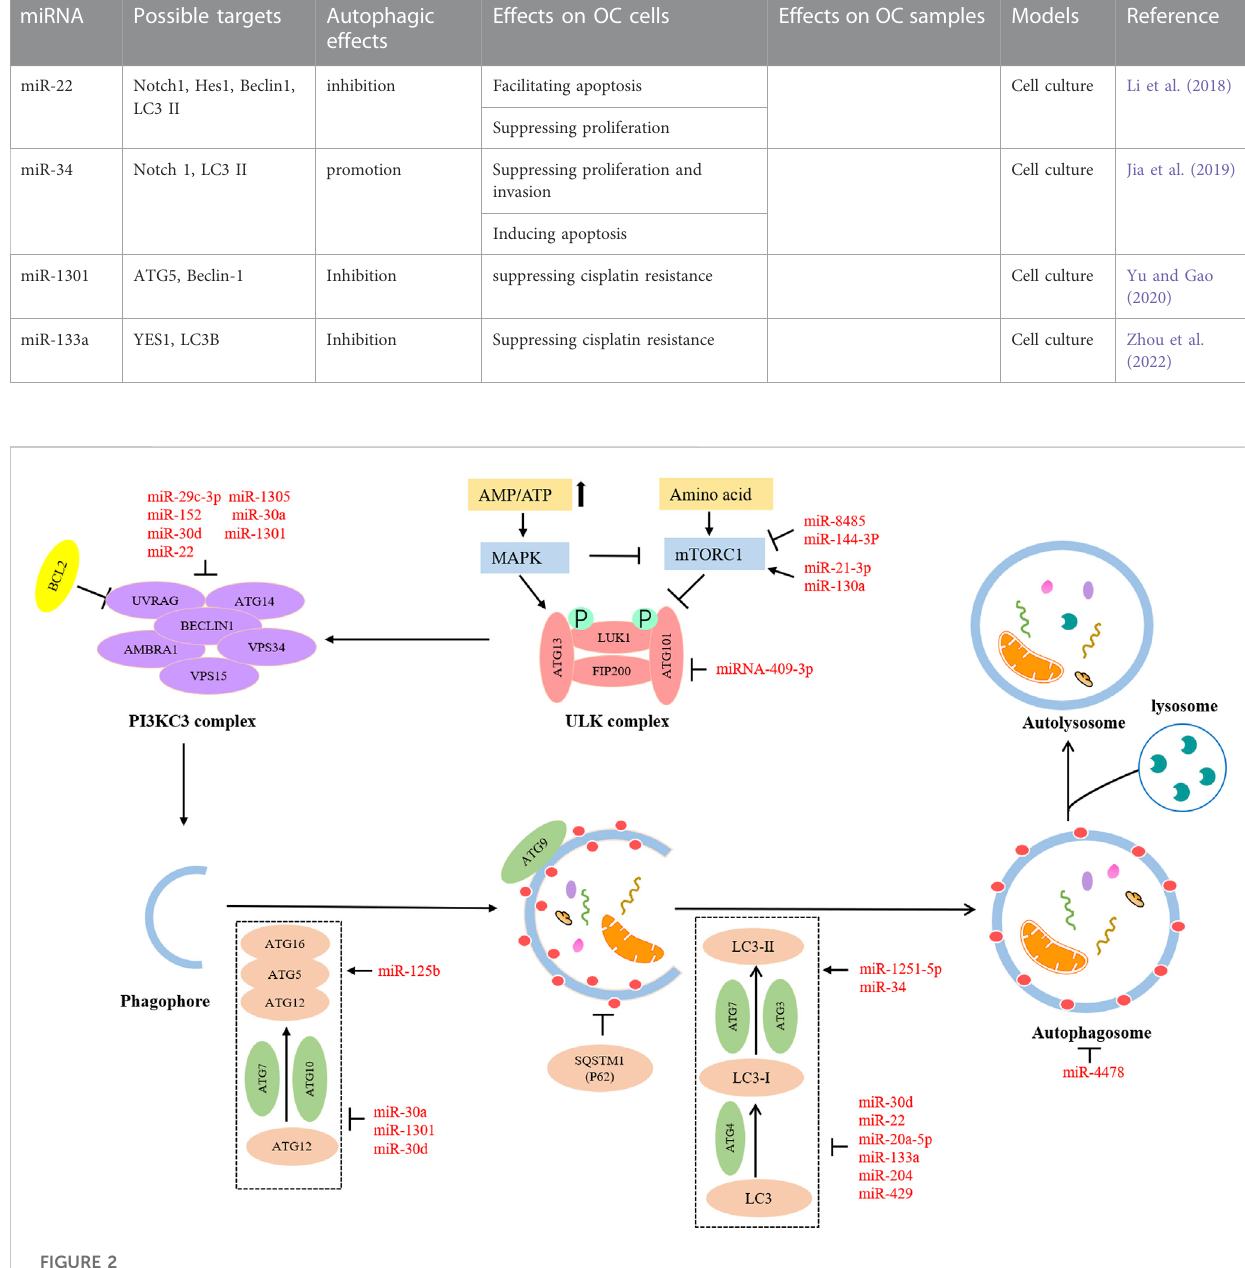
FIGURE 2 Roles of miRNAs in autophagy regulation in